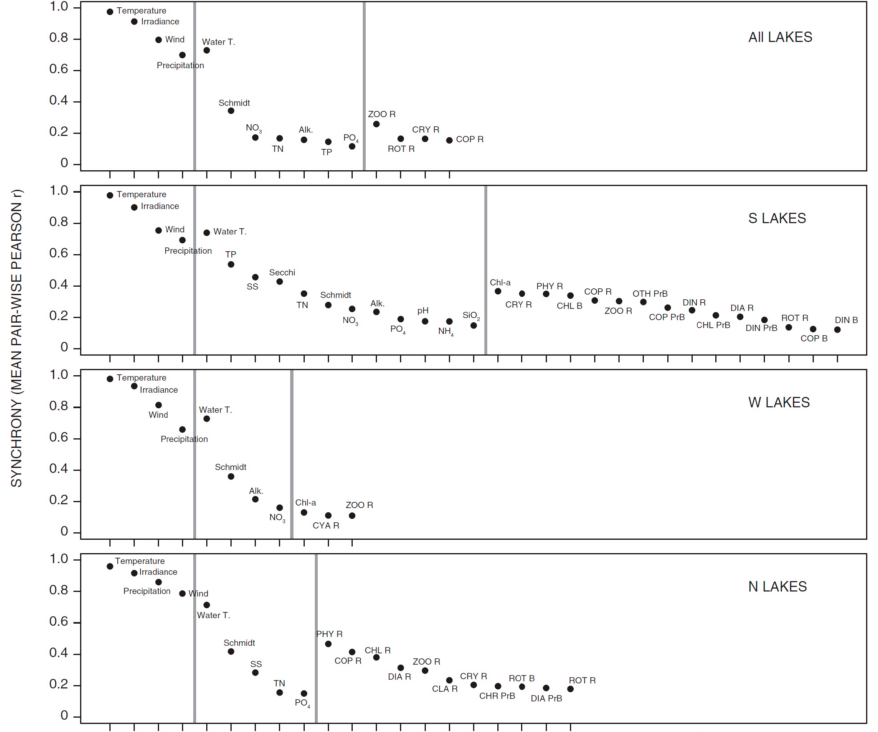
Figure A3. Summary of synchrony in climate, lake and plankton variables in summer analysed for all lakes and for S, W and N lakes separately. For details see Figure 3.